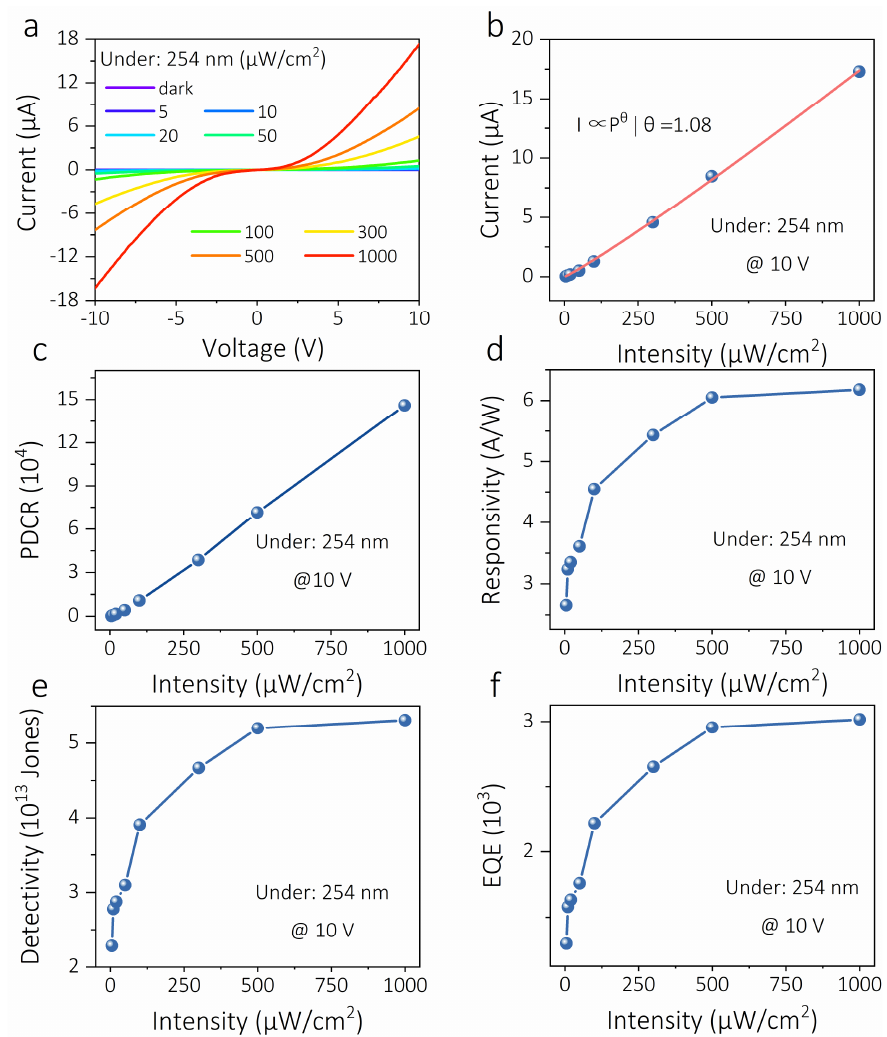
Figure 3. ( a ) Characteristic I – V curves of PD under 254 nm light with different light intensities. ( b ) Photocurrent, ( c ) light–dark current ratio, ( d ) responsivity, ( e ) detectivity, and ( f ) external quantum efficiency of the device as a function of light intensity under 245 nm